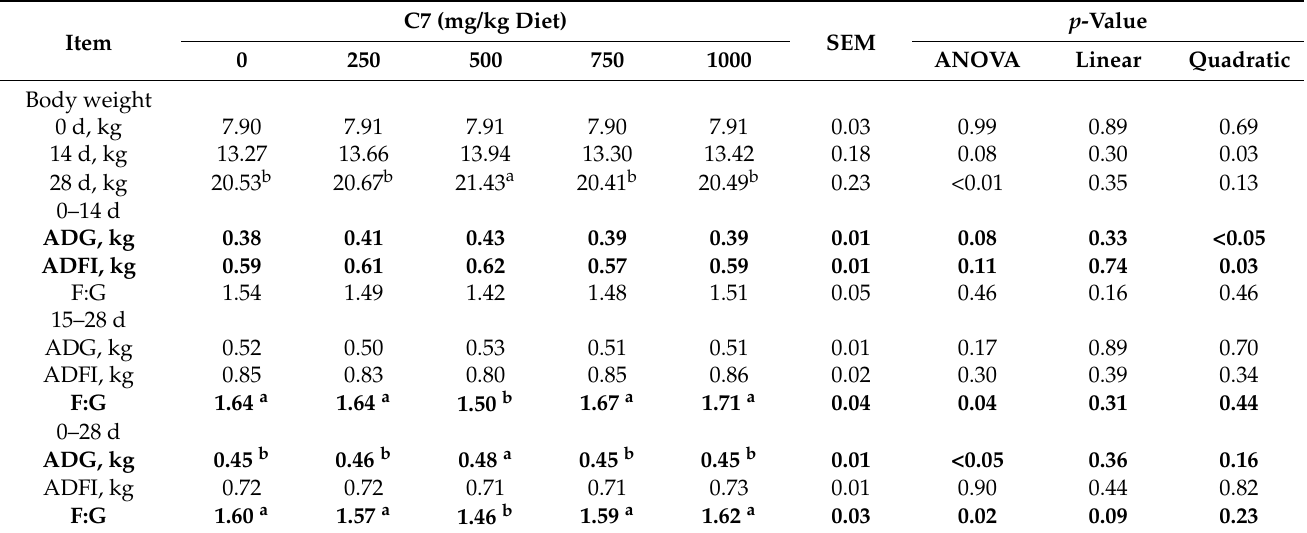
Table 4. Effects of dietary C7 supplementation on growth performance.